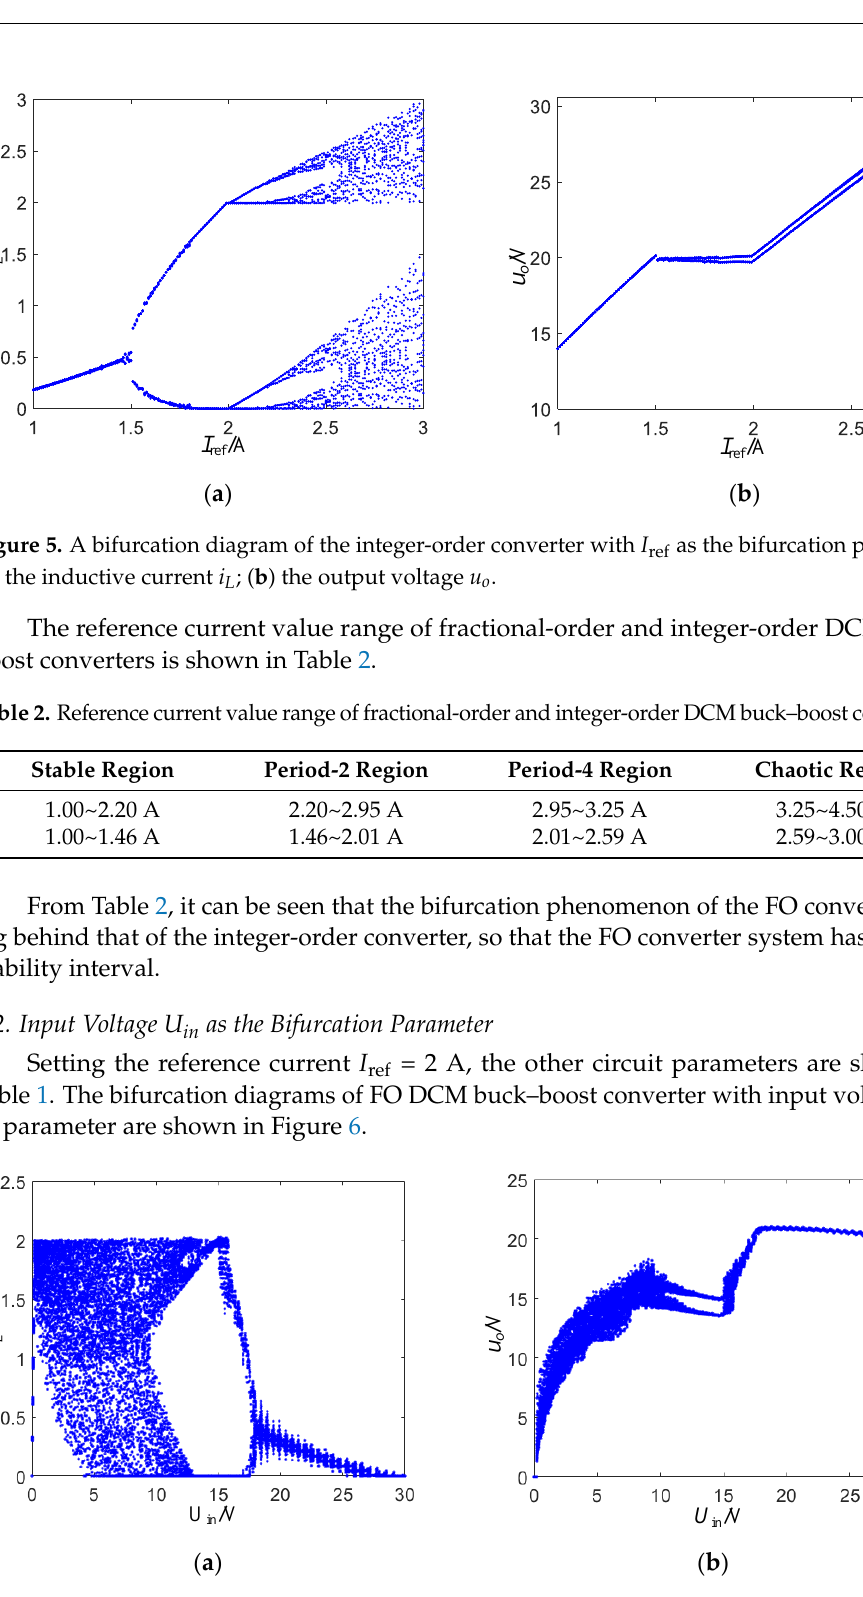
the inductive current i L ; ( b ) the output voltage u o .